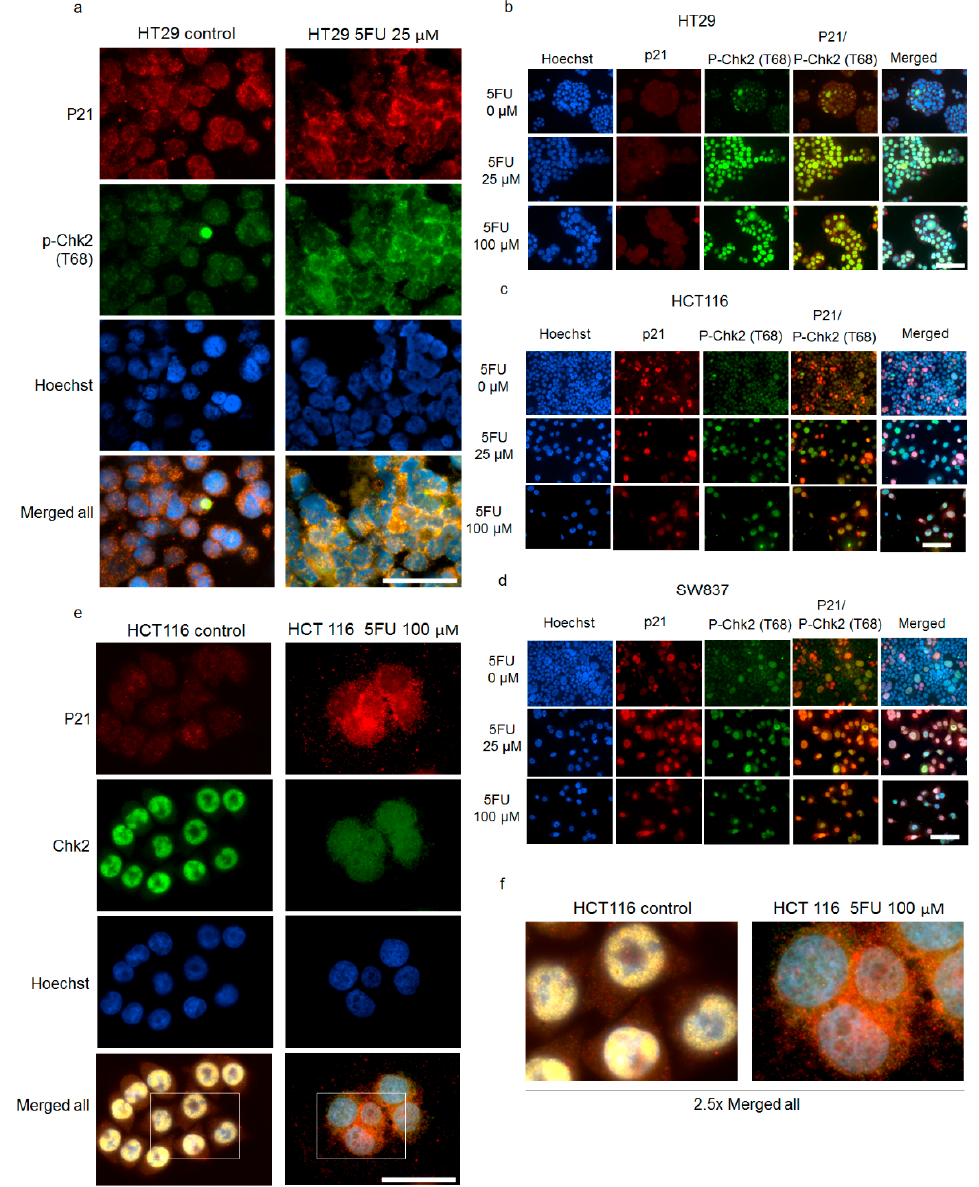
Figure 6. Co-localization of p21 and p-Chk2 T68 /Chk2 in 5FU-resistant cells. ( a , b ) HT29, ( c ) HCT116 and ( d ) SW837 cells were treated with various concentrations of 5FU for 48 h and the expression of p21 and p-Chk2 T68 was examined by immunofluorescence staining using mouse anti-p21 monoclonal antibodies followed by an Alexa Fluor 555-labeled secondary antibody to visualize p21 expression (red), rabbit anti-p-Chk2 T68 monoclonal antibodies followed by an Alexa Fluor 488-labeled secondary antibody to visualize p-Chk2 T68 expression (green) and cell nuclei (Hoechst 33342, blue). ( a ) Enlarged images of p21 and p-Chk2T68 co-localization in 5FU-resistant HT29 cells. Scale bar: 50 µ m; ( e ) HCT116 cells were treated with 100 µ M 5FU for 48 h and the expression of p21 and Chk2 was examined by immunofluorescence staining using mouse anti-p21 monoclonal antibodies followed by an Alexa Fluor 555-labeled secondary antibody to visualize p21 expression (red), rabbit anti-Chk2 monoclonal antibodies followed by an Alexa Fluor 488-labeled secondary antibody to visualize Chk2 expression (green) and cell nuclei (Hoechst 33342, blue). Scale bar: 50 µ m; and ( f ) 2.5-fold computer-enlarged images from merge images in ( e ).